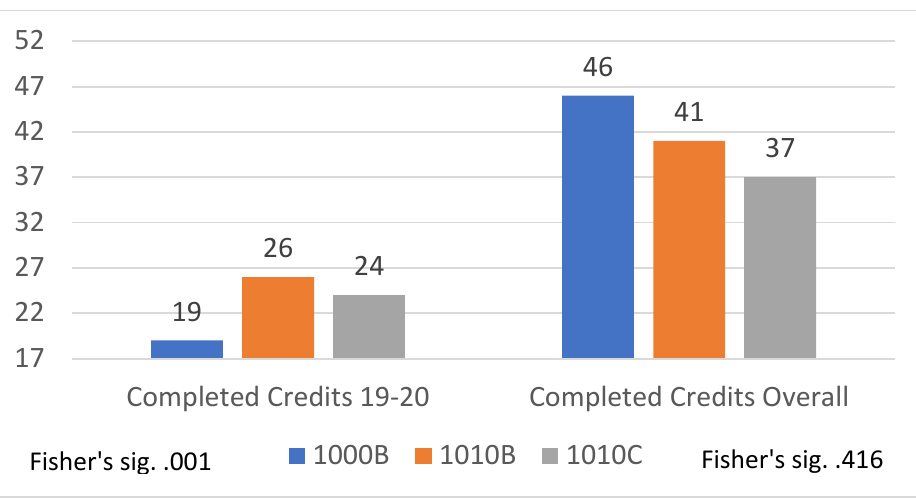
FIGURE 6. COMPLETED CREDITS BY